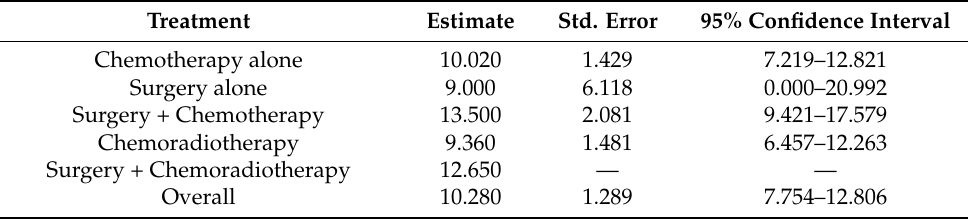
Table 4. Median months survival by treatment